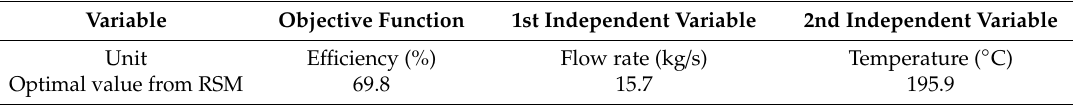
Table 5. The optimal boiler efficiency (obtained from the RSM).